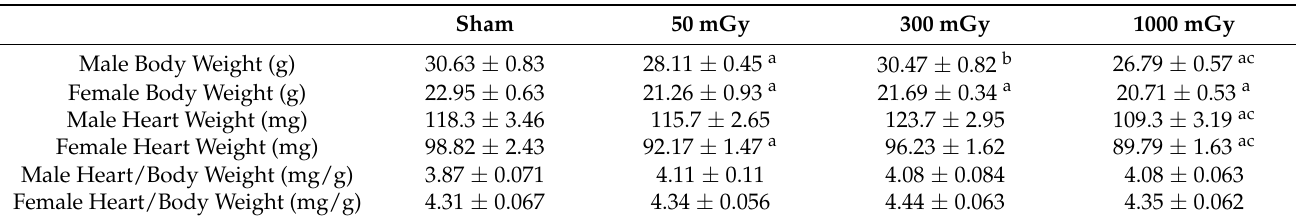
Table 1. Male and female body, heart weights, and heart/body ratios in offspring after receiving Sham, 50, 300, or 1000 mGy gamma radiation in utero. Sham Male Body Weight